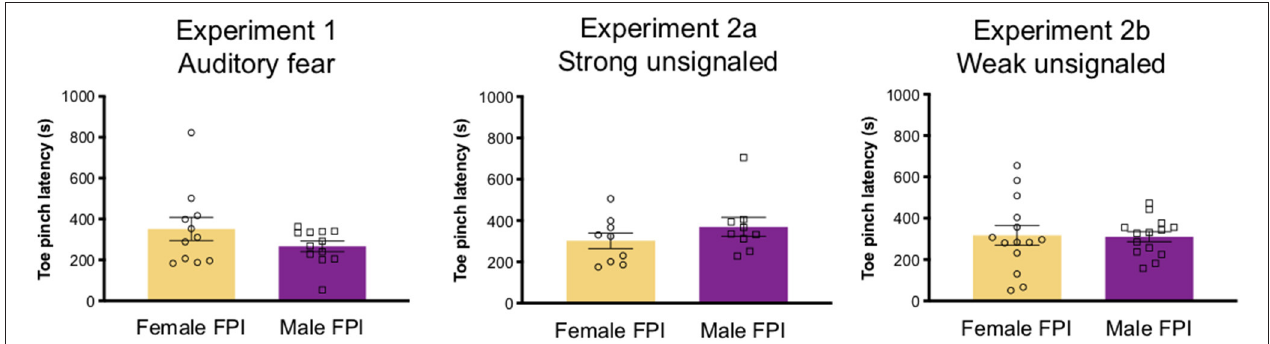
FIGURE 1 | Injury severity across experiments. Although drop angle was adjusted between sexes in lateral fluid percussion injury settings (angle 13 for females, 14 for males), injury severity was balanced across sexes for all experiments as measured by latency for toe pinch withdrawal after impact. Data are represented as mean ± SEM; n = 9–14/group depending on the